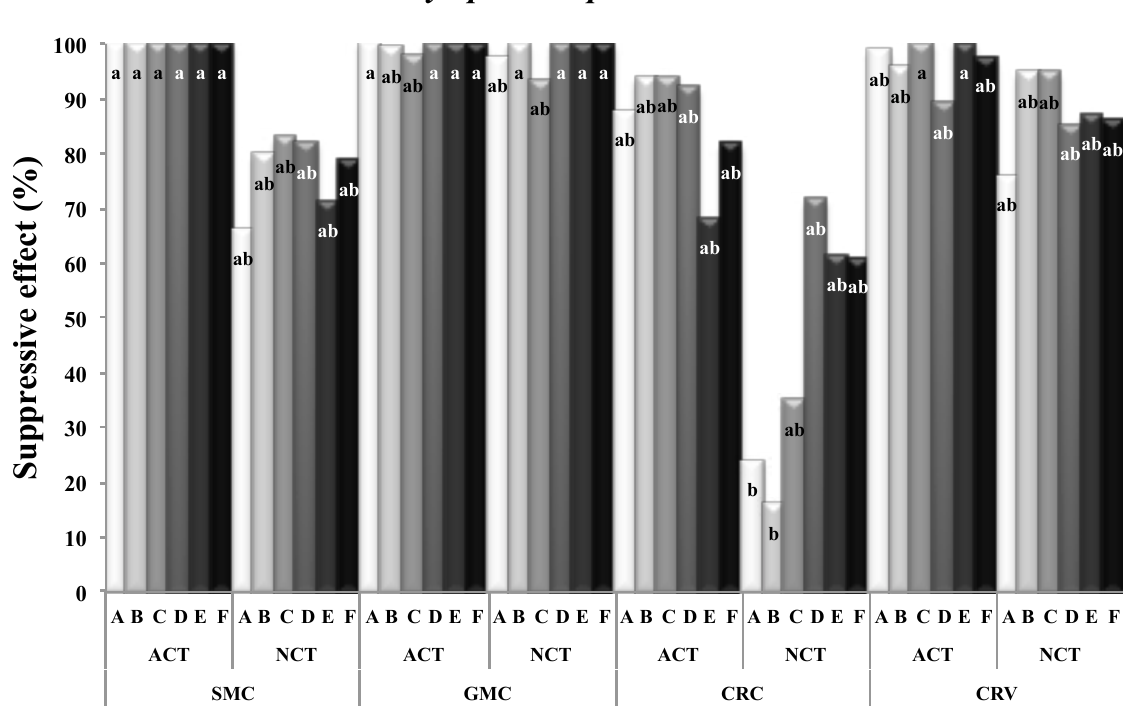
Figure 2. Inhibition percentages of Phytophthora parasitica colonies in agar plates containing medium augmented with aer - ated compost tea (ACT) and non-aerated compost tea (NCT) from spent mushroom compost (SMC), grape marc compost (GMC), crop residues compost (CRC) and crop residues vermicompost (CRV). Compost teas were obtained in ratio 1:3 w:v and incorporated into PDA to concentrations of 5% (A), 10% (B) and 15% (C) v:v and ratio 1:4 weight:volume and incorporated into PDA to concentrations of 5% (D), 10% (E) and 15% (F) v:v. Different letters indicate significant differences according to One-Way ANOVA tests ( P